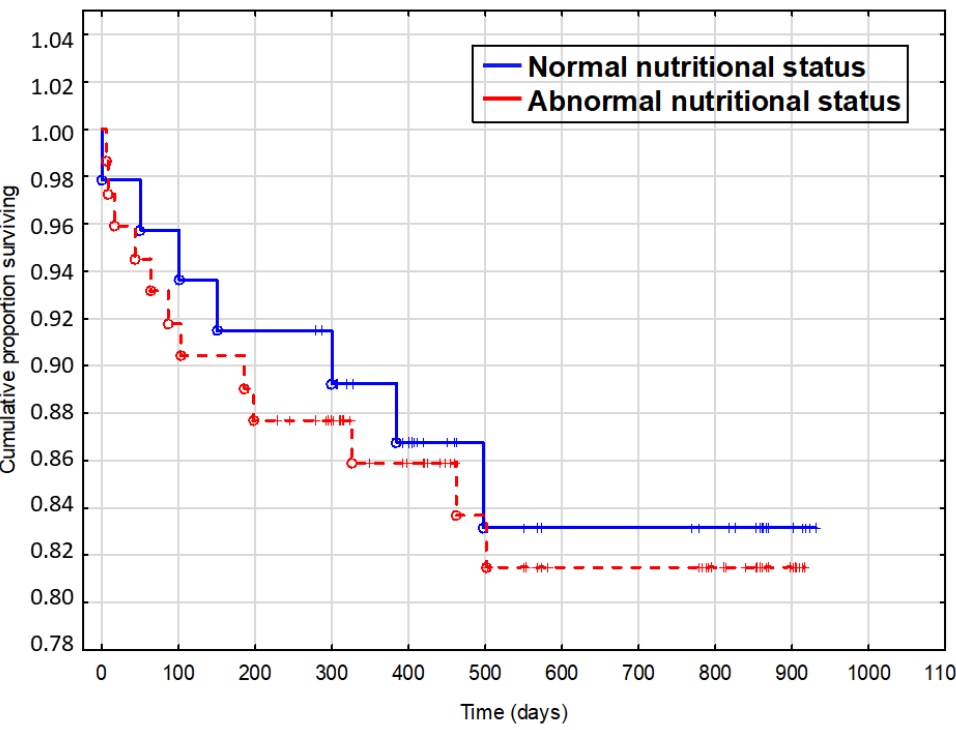
Figure 1. Influence of nutritional status on survival.